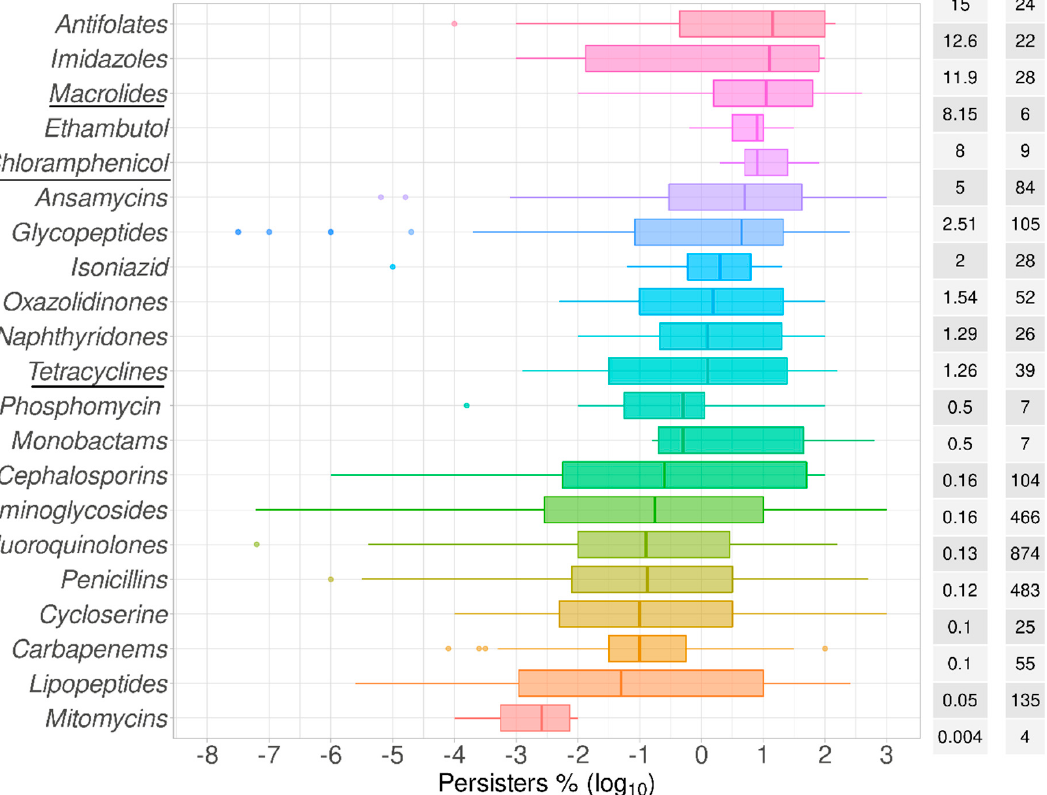
Figure 4. Persisters as compared by antibiotic classes. Antibiotics were grouped into 19 different classes according to their known chemical similarity (Table 2). These antibiotic classes were listed in the order of the median value as plotted as box plots of the percentage of cells surviving the exposure to each of these antibiotics in comparison to time zero in time–kill assays, or in comparison to the control without antibiotics in one-time-point experiments. Bacteriostatic antibiotics are underlined. The abscissa represents the spread of the data as log 10 values of the percentage of persisters. The median value for the percentage of surviving cells is listed in the median % column followed by the total number of time points collected for each species ( n ).